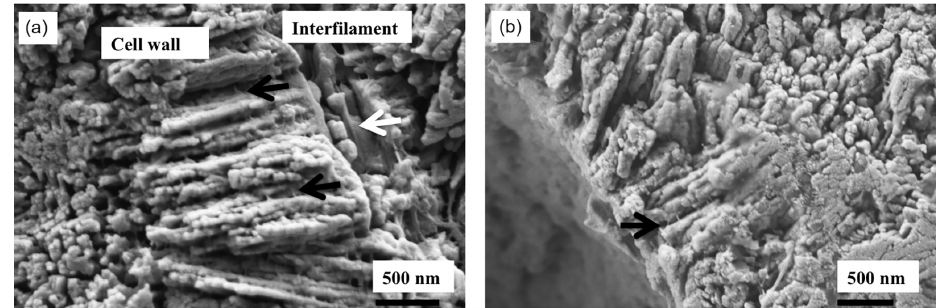
Figure 8. L. laeve cell wall structure. (a) Cleaned for 2min. Cell wall radial crystals are 1.5µm length cylindrical grains. Fibrils are present (black arrows) but not as easy to see as in the K. epilaeve . Interfilament grains parallel to cell wall, with organic fibrils (white arrows) also running parallel to cell wall. (b) Etched for 20min. Fibrils appear similarly to in the K. epilaeve with the fence post-wire structure (black arrows).